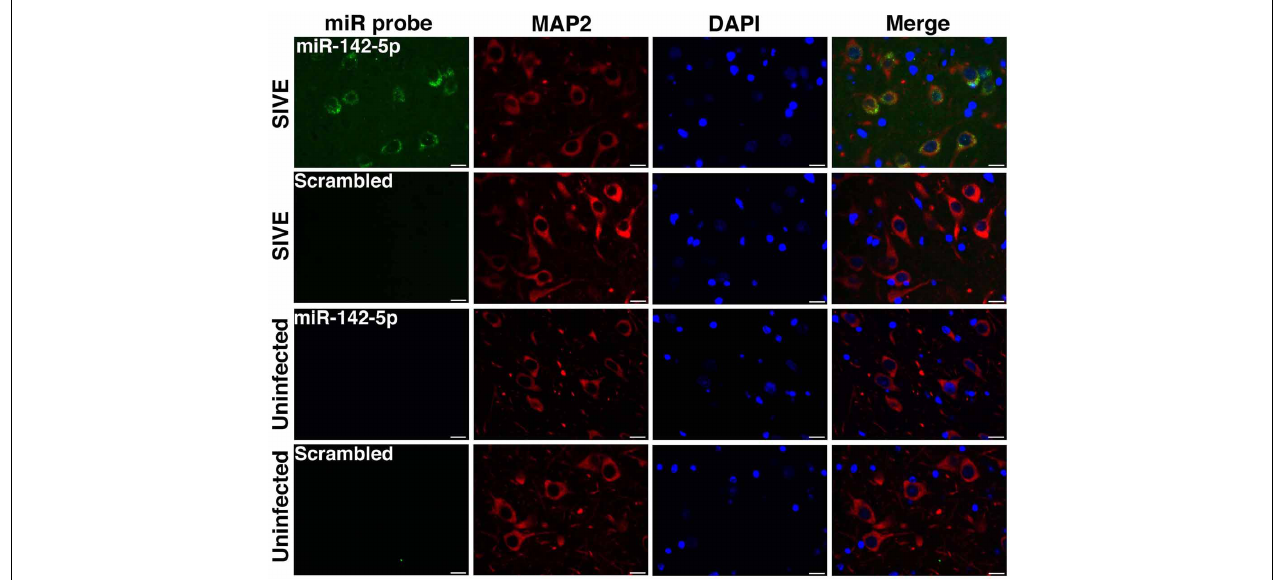
FIGURE 3 | MiRNA-142-5p is expressed in neurons in SIVE. Combined FISH and IF was performed for miRNA-142-5p and MAP2 in FFPE hippocampal sections from rhesus macaques with SIVE and uninfected macaques. MiRNA-142-5p expression (green) was detected within